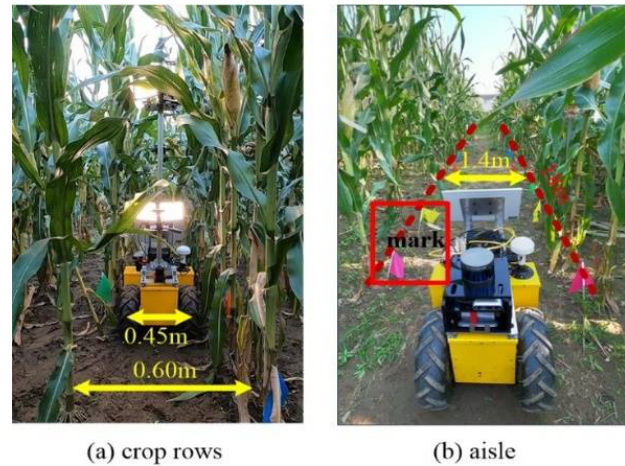
Figure 3. The experimental scenarios. ( a ) crop rows; ( b ) aisle.